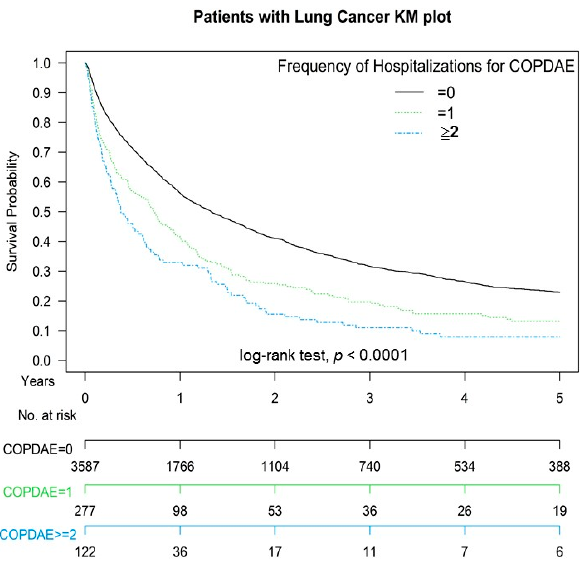
Figure 1. Kaplan-Meier overall survival curves of propensity score-weighted population of ad- vanced stage lung squamous cell carcinoma with or without chronic obstruction pulmonary dis- ease before concurrent chemoradiotherapy.